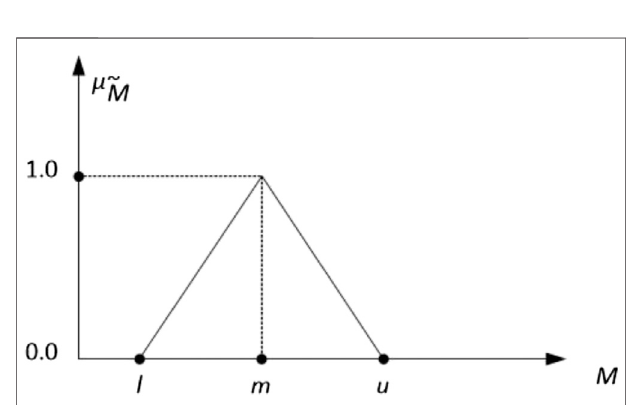
FIGURE 2 | The presentation of a triangular fuzzy